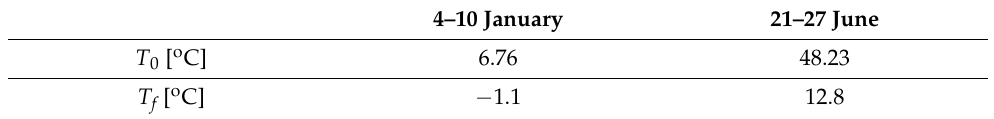
Table 5. Parameters for dimensionless temperature calculation in the given